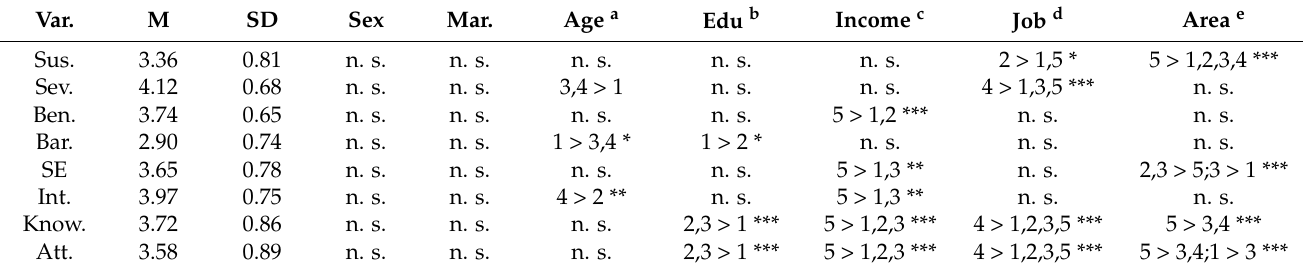
Table 3. Summary of the results of the t -tests and ANOVA. M = mean; SD = standard deviation; n. s. = non-significant; Sus. = perceived susceptibility; Sev. = perceived severity; Ben. = perceived benefit; Bar. = perceived barrier; Int. = PSU intention; SE = Self-efficacy; Know. = knowledge; Att. = Attitude; * p < 0.05, ** p < 0.01, *** p < 0.001. a 1. < 30, 2. 31–40, 3. 41–50, 4. 51–60, 5. 61 & up; b 1. High school and lower, 2. Bachelor, 3. Masters and up; c 1. < 30 K, 2. 31–40 K, 3. 41–50 K, 4. 51–60 K, 5. 60 K &